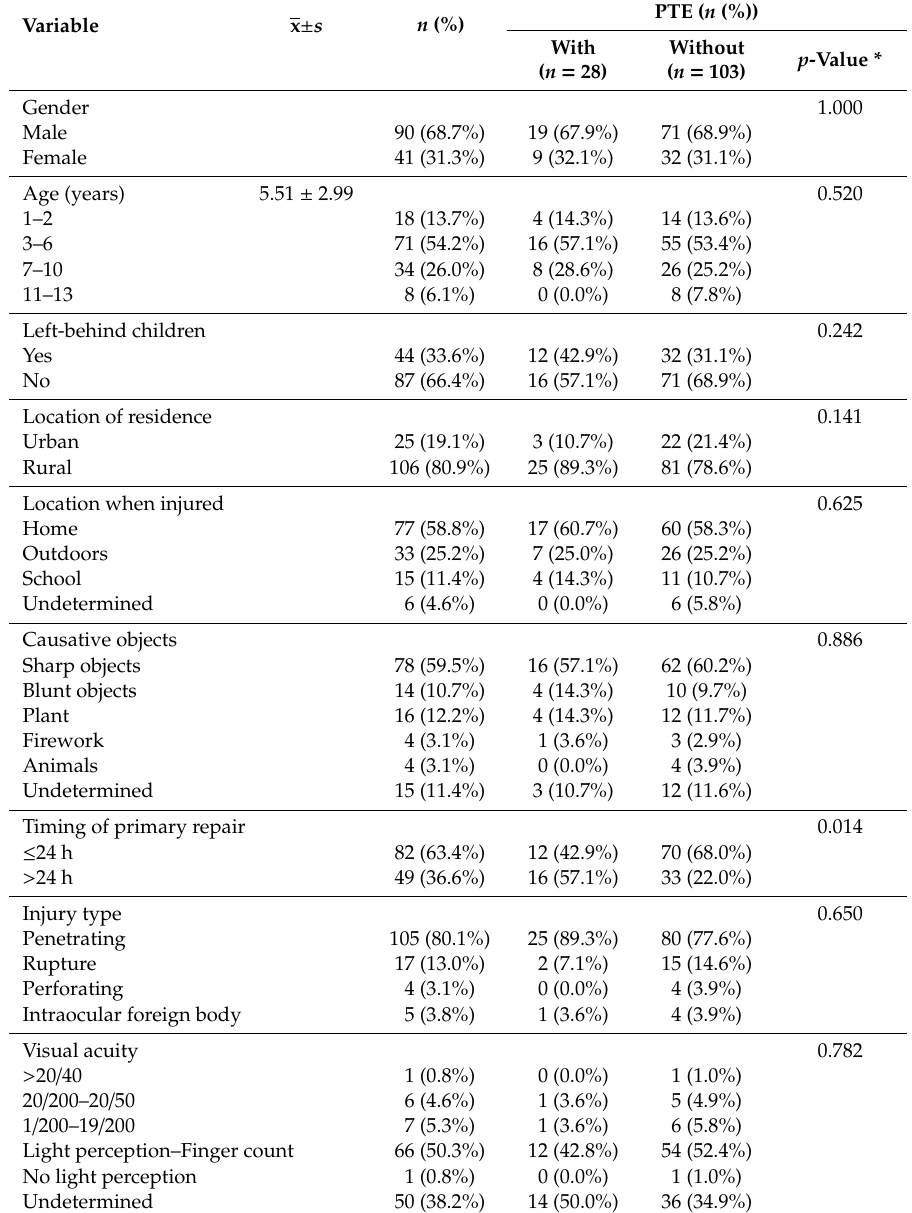
Table 1. Clinical features of pediatric open globe injuries patients ( n = 131).